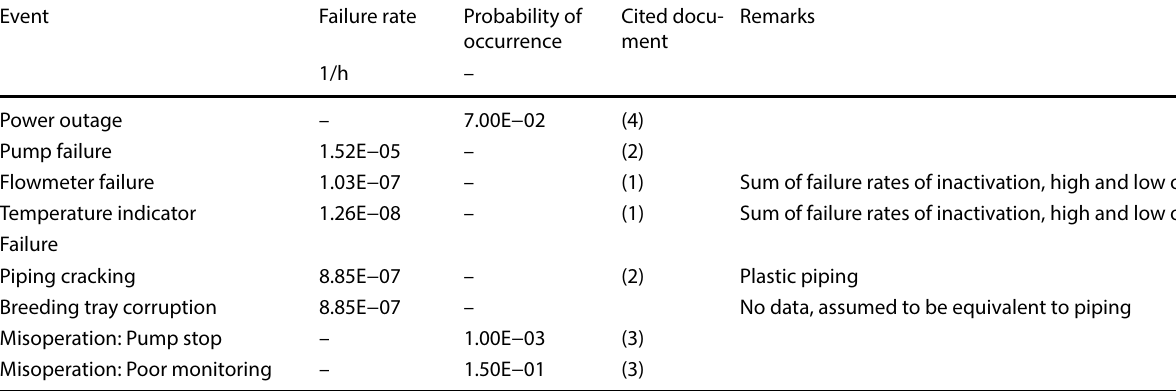
Table 3 Failure rate and human error probability